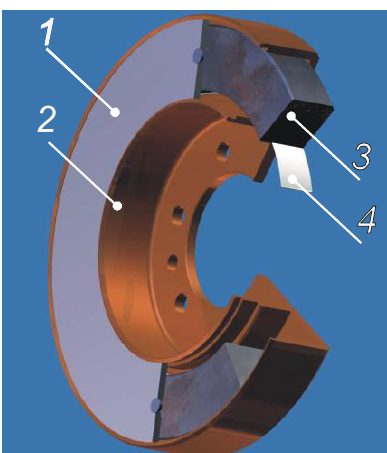
Figure 5. Viscous vibration damper: 1—cover, 2—housing, 3—inertia ring, 4—bearing [7].